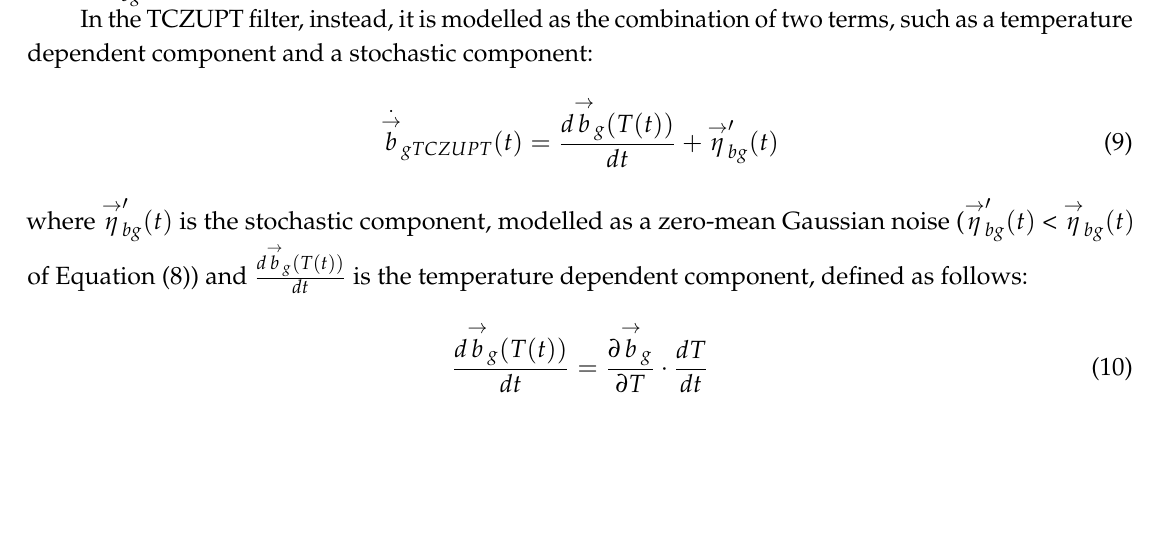
Figure 4. TCZUPT filter: a is the accelerometer output, ω RAW is the raw gyro data and b a and b g are respectively the accelerometer and gyro